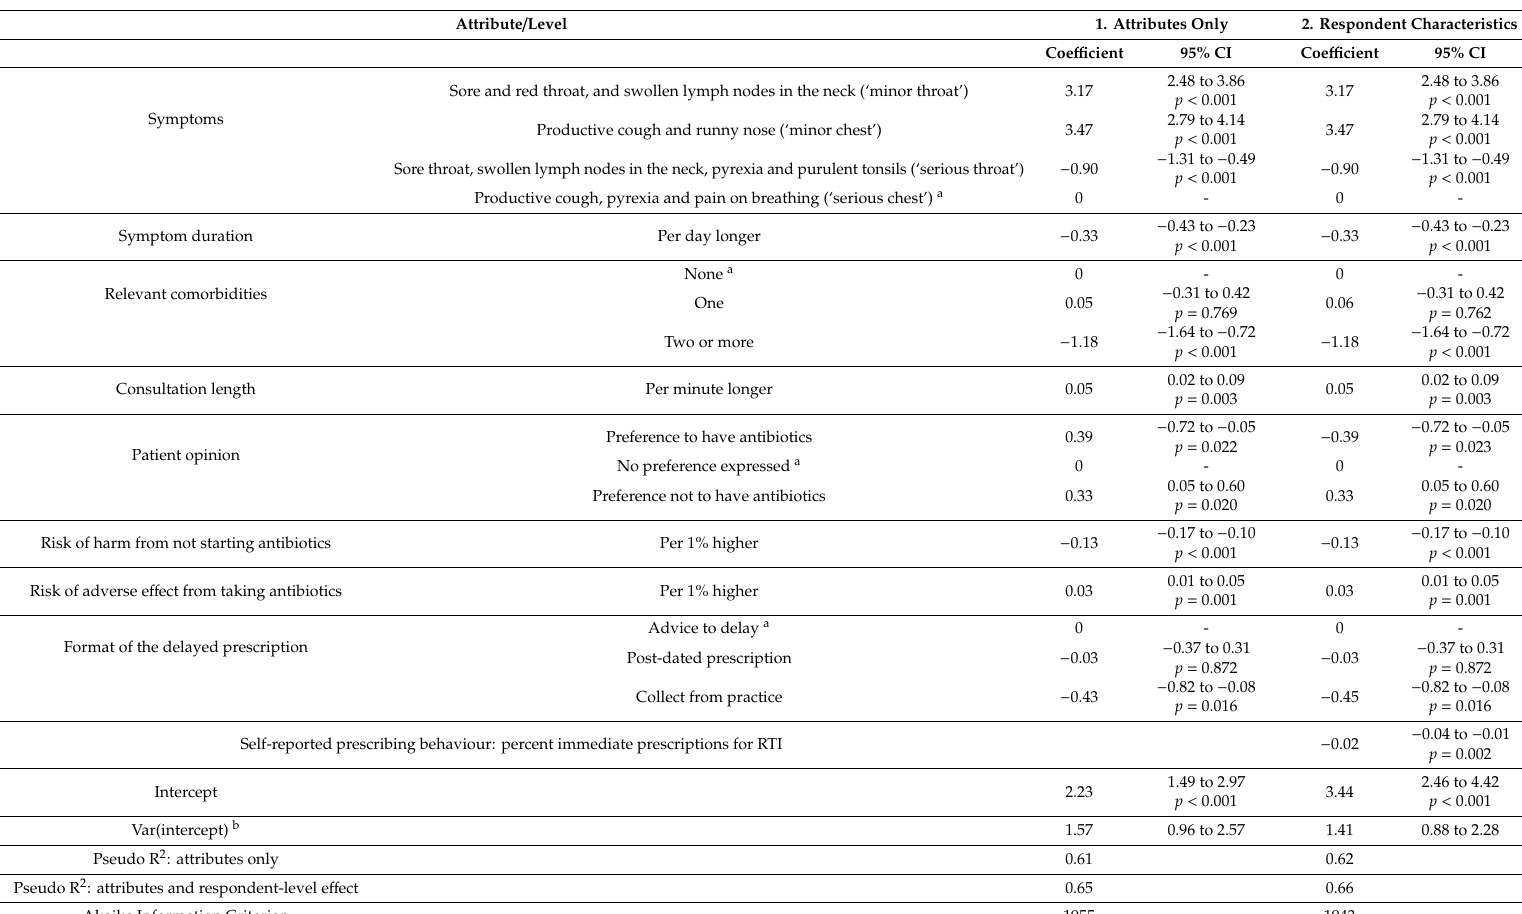
Table 3. E ff ect of attributes on preferences for delayed